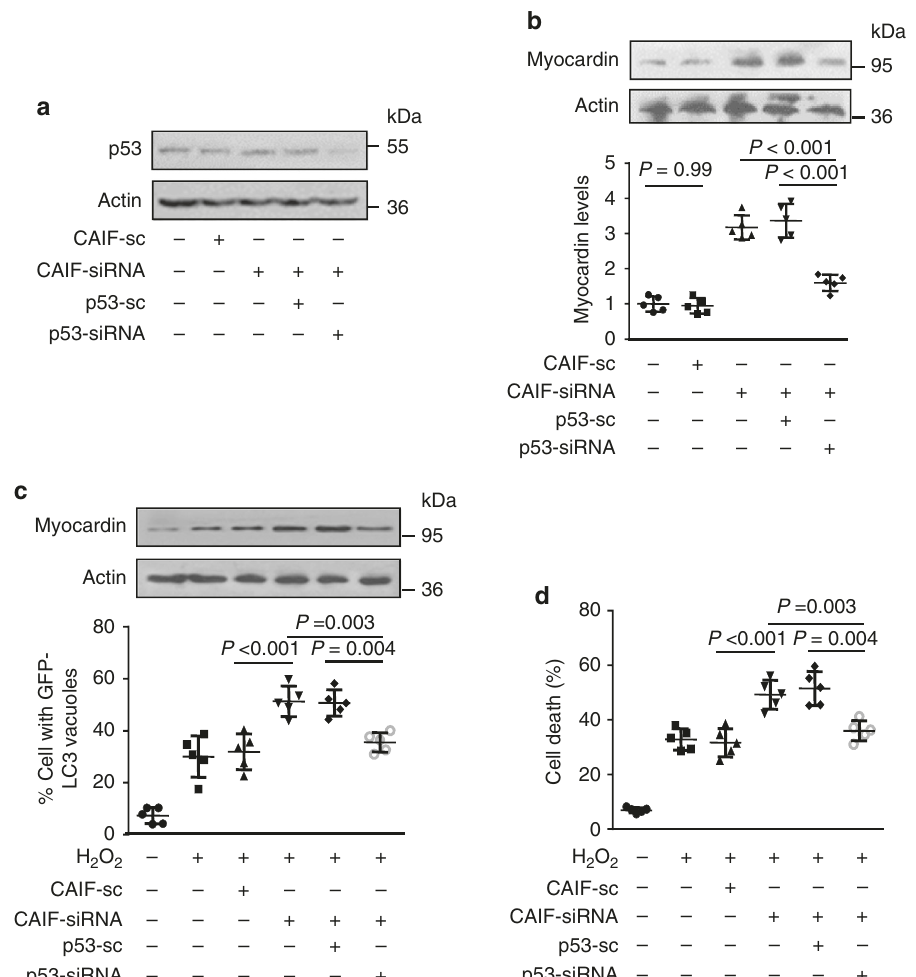
Fig. 6 CAIF exerts its autophagic effect through p53 and myocardin. a , b Knockdown of p53 reduces the promoting effect of CAIF knockdown on myocardin expression. Cardiomyocytes were infected with adenoviral CAIF-siRNA or CAIF-sc, p53-siRNA or p53-sc. p53 expression levels were analyzed by immunoblot ( a ). Myocardin expression levels were analyzed by immunoblot ( b , upper panel) and by qRT-PCR ( b , low panel). n = 5. c , d Knockdown of p53 attenuates the promoting effect of CAIF knockdown on autophagy and cell death induced by H 2 O 2 . Cardiomyocytes were infected with adenoviral CAIF- siRNA or CAIF-sc, p53-siRNA or p53-sc, and then exposed to H 2 O 2 . Myocardin levels were analyzed by immunoblot ( c , upper panel). Autophagy was assessed by GFP-LC3 staining. The percentage of cells with GFP-LC3 puncta was quanti fi ed in ( c , low panel). n = 5. Quantitation of cell death is shown in ( d ). n =